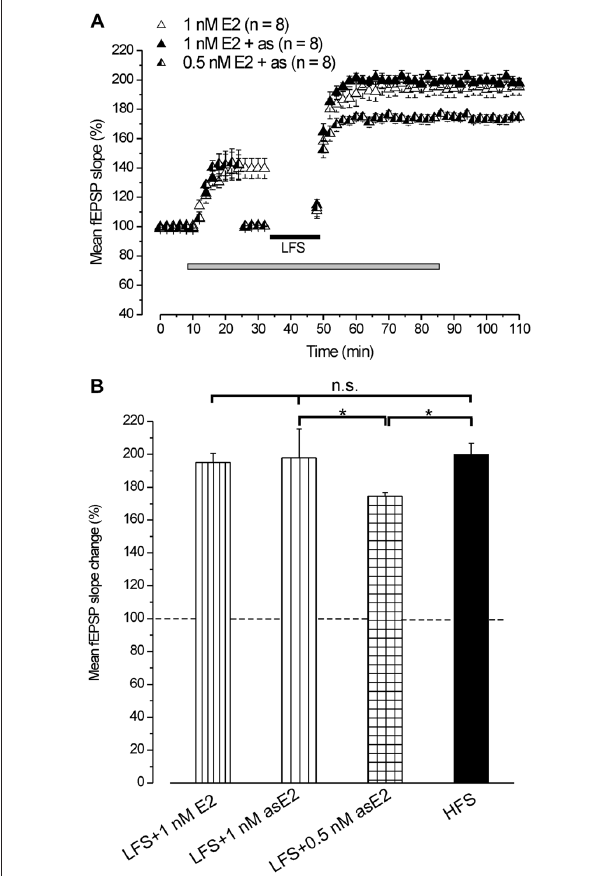
FIGURE 2 | Exogenous administration of E2 reverts the LFS-LTD into LFS-LTP. (A) Effect of LFS in the presence of 1 nM E2 (open triangles) without stimulus adjustment and 1 nM (filled triangles) or 0.5 nM E2 (half-filled triangles) with stimulus adjustment (as). (B) Comparison among LTP induced by HFS in control condition and by LFS in the presence of E2 at different concentrations and stimulus adjustment (one-way ANOVA, F 3,37 = 2.86, p < 0.05; Tukey’s post hoc test, ∗ p < 0.05).